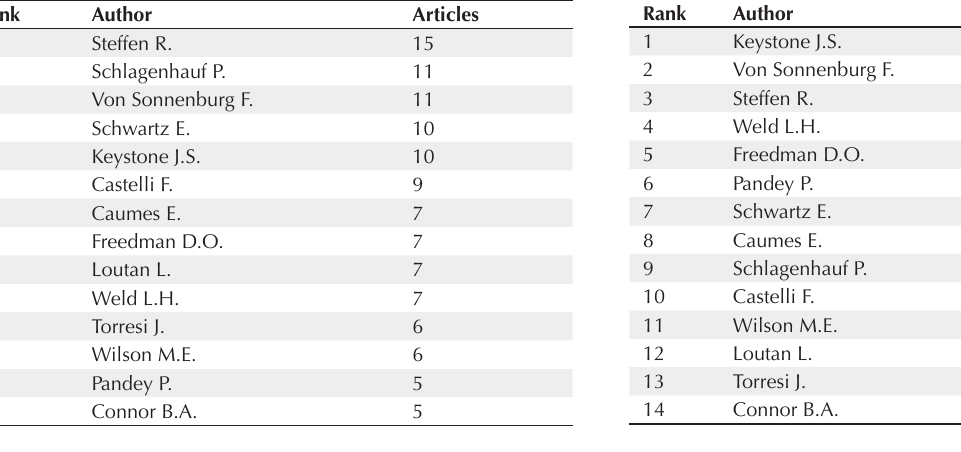
Table 3. Authors With Five or More Publications in the Top-Cited Articles